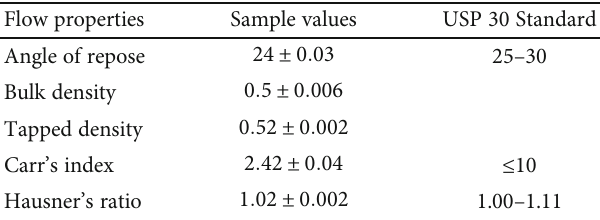
Table 3: Evaluation of fl ow properties of granules and compared it with USP 30